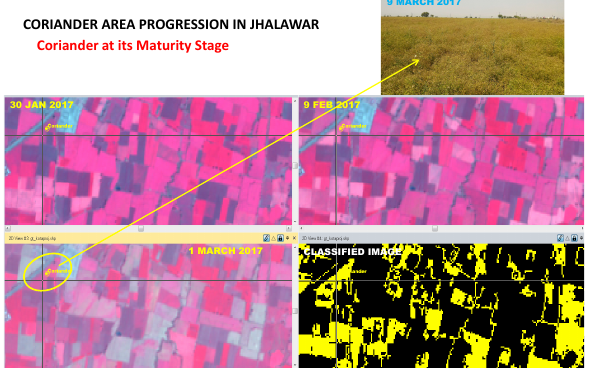
Figure 6. The Field Photograph was collected on 9 th March 2017 when most of the fields were in mature stage. In some patches however coriander was still at its flowering stage To evaluate separability of different competing crops on monotemporal image of 9th February 2017, feature space plot (Figure 7) of different training signatures was generated with 95 percent confidence ellipse. Reflectance from Red band was plotted on X axis and NIR band on Y axis. 95 percent confidence ellipses represent the pixels assigned to each object area using a maximum likelihood classifier with 2 standard deviation from the mean (Ommeren, 2016). Dasgupta et.al., (2013) showed a single class of a single parameter with mean μ and standard deviation σ, the values falling beyond μ + 2σ and μ − 2σ are not representing that class, but a transitional zone between two subsequent classes. Hence this threshold was chosen as a decision boundary to separate two class. Looking at the feature space plot, it becomes clear that wheat and coriander at flowering stage was easier to separate on the February image. However there was considerable spectral overlap with mustard and coriander at mature and vegetative stage owing to similar reflectance pattern. Mean spectral profile of different crops (Figure 8) also conforms the same.